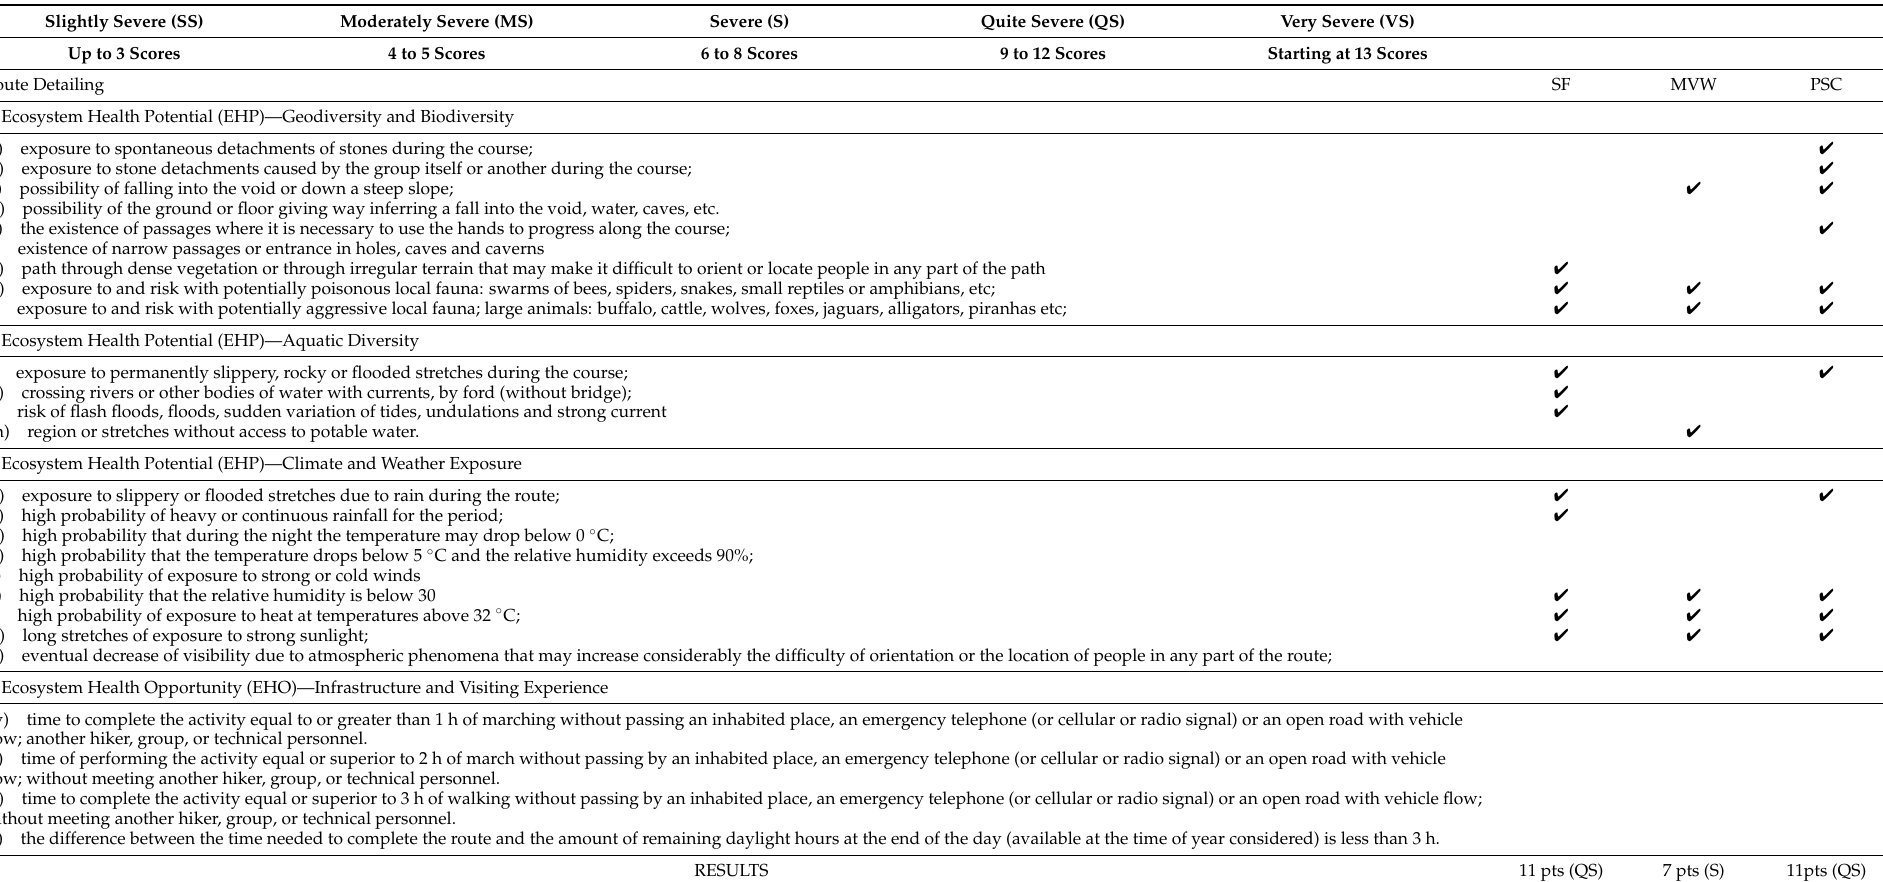
Table 4. Psychometric Rating of the Severity of the Environment: S í tio Fund ã o, Miss ã o Velha Waterfall and Pontal de Sta. Cruz trails; Araripe